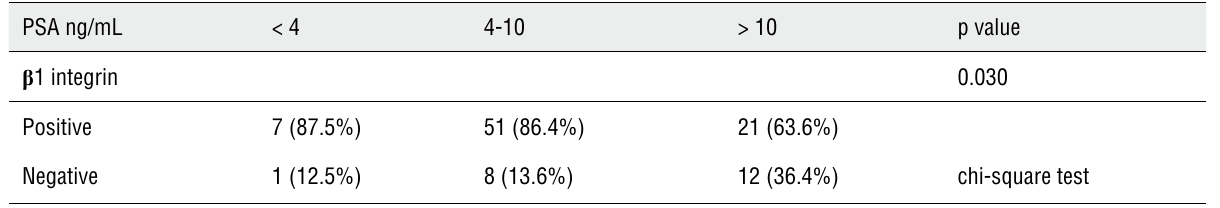
Table 4 - β 1 integrin expression according to PSA serum level.